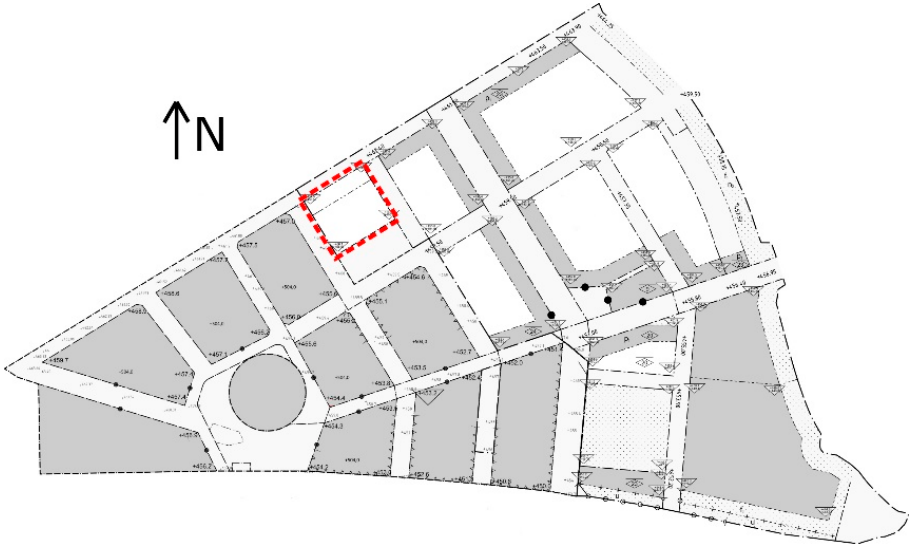
Figure 3. Location of the residential block in relation to adjacent urban elements.